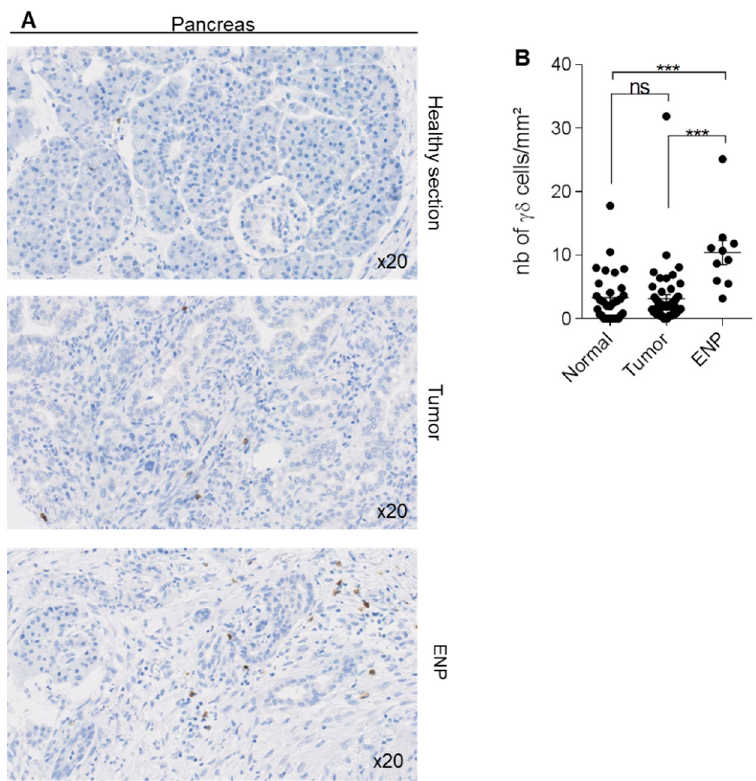
Figure 5. Detection of γδ T-cells in human pancreatic tissue samples. Immunohistochemical detection of γδ T-cells in 50 pancreatic adenocarcinomas, 31 adjacent normal pancreatic sections, and 10 epineoplastic pancreatitis (ENP) samples. ( A ) The figure shows one representative normal pancreas section, one representative tumor section, and one representative ENP section. ( B ) Scatter plot comparing γδ T-cell density in normal, pancreatic cancer, and ENP samples. Data are the mean ± SEM. Ns: non-significant; *** p = 0.0001 (Kruskal–Wallis with Dunn’s multiple comparison test).